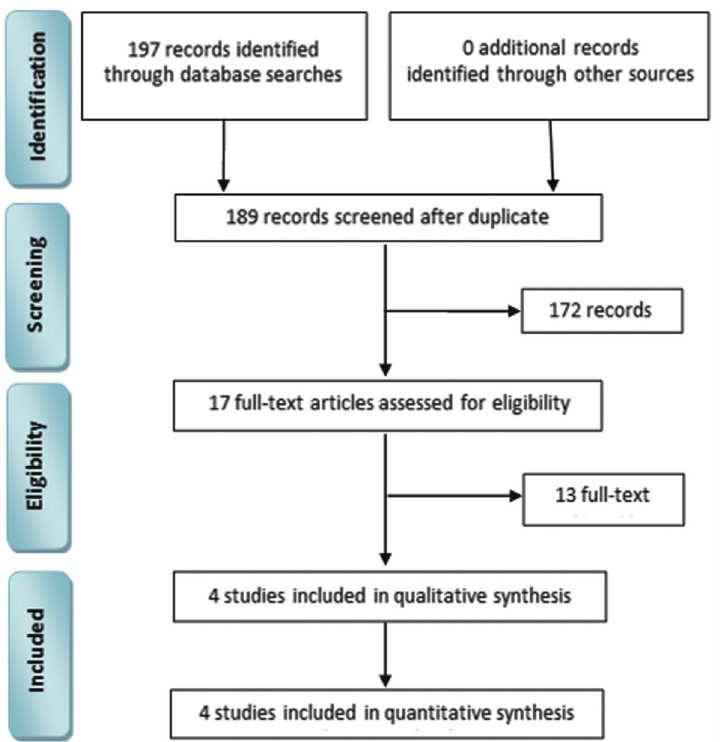
Figure 1. Identi fi cation process for study inclu- sion in the